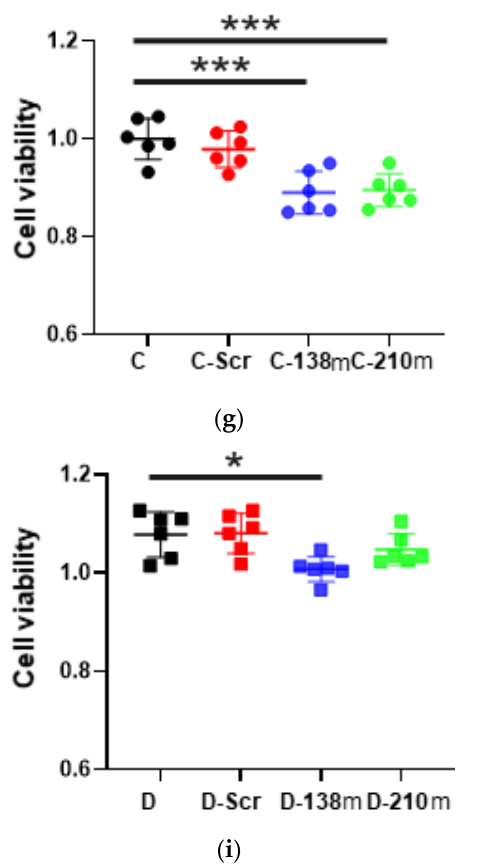
Figure 2. The changes of cell migration and proliferation after inhalational anaesthesia with mimic miRNA pretreatment. ( a – f ) SKOV3 cell migration analysis with wound healing assay after 2 h of inhalational anaesthesia with miRNA inhibition pretreatment at 0 h (upper) and 8 h (bottom) after anaesthesia. ( a ) The microscopic images after control anaesthesia. ( b ) The comparison of gap closure percentage with control anaesthesia and mimic miRNA pretreatment. ( c ) The microscopic images after 3.6% sevoflurane anaesthesia with mimic miRNA pretreatment. ( d ) The comparison of gap closure percentage with 3.6% sevoflurane anaesthesia and mimic miRNA pretreatment. ( e ) The microscopic images after 10.4% desflurane anaesthesia with mimic miRNA pretreatment. ( f ) The comparison of gap closure percentage with 10.4% desflurane anaesthesia and mimic miRNA pretreatment. ( g – i ) Cell proliferation analysis with CCK8 assay with anaesthesia and mimic miRNA pretreatment relative to each control group at 24 h after exposure: ( g ) control anaesthesia, ( h ) 3.6% sevoflurane anaesthesia and ( i ) 10.4% desflurane anaesthesia. Data showed as plots and mean ± SD. * p < 0.05, ** p < 0.01, *** p < 0.001,